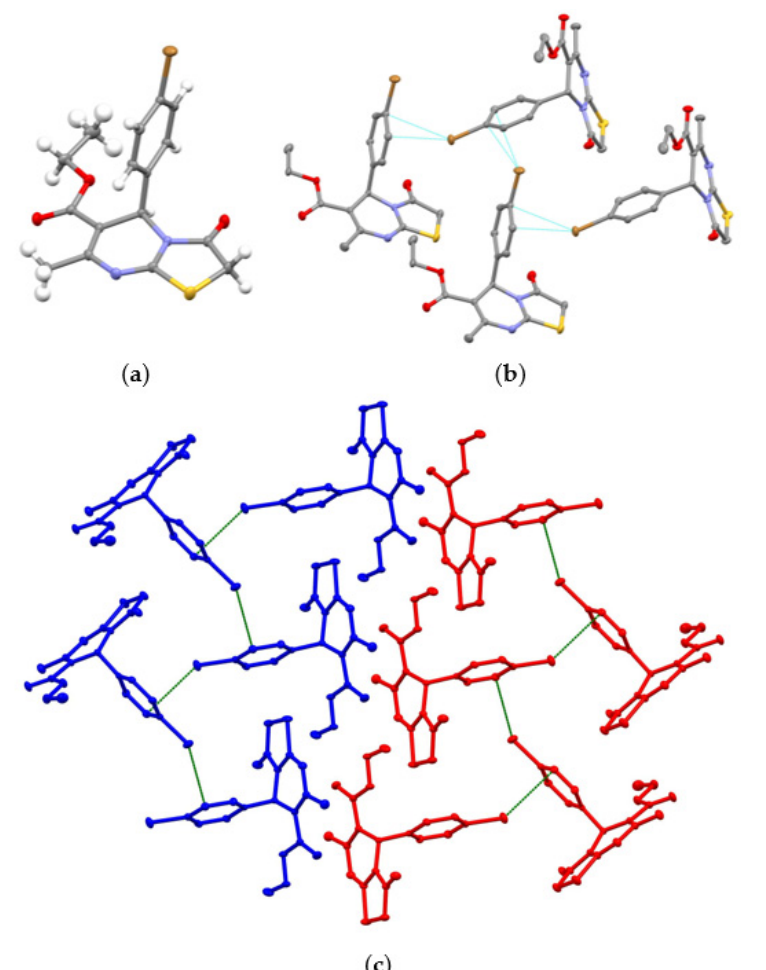
Figure 1. ORTEP view of molecule 7 in the crystalline phase ( a ) (Br, C, O, N, S, and H-atoms are presented as brown, grey, red, light-violet, yellow, and light grey ellipsoids with a 50% probability, respectively), a mutual orientation of R-isomers of 7 within the zigzag homochiral chain formed by Br1…C13 n- π interaction ( b ), and a portion of crystal packing of 7 showing the formation of parallel R- and S-homochiral chains along b axis (colored in blue and red, respectively) ( c ) (H-atoms are omitted for clarity).